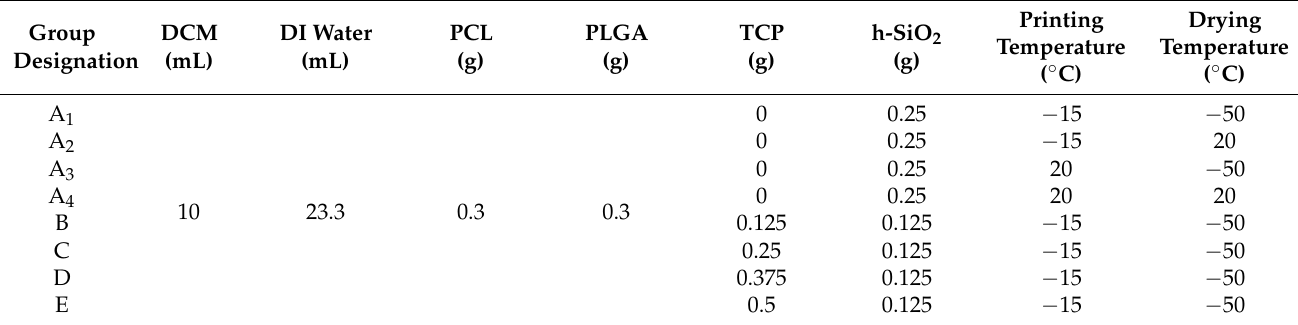
Table 1. Compositions of different Pickering emulsion